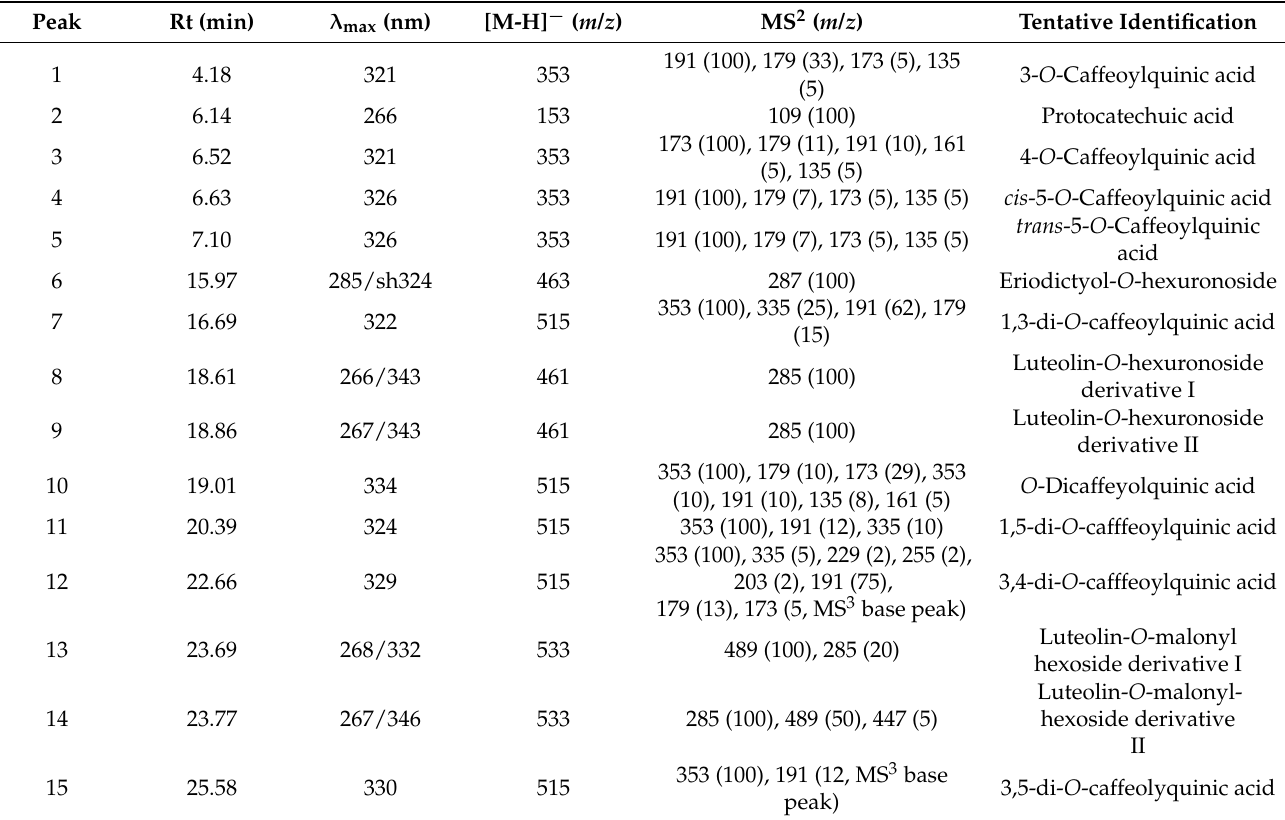
Table 1. Phenolic compounds tentatively identified in the hydroethanolic extracts of cardoon petioles.